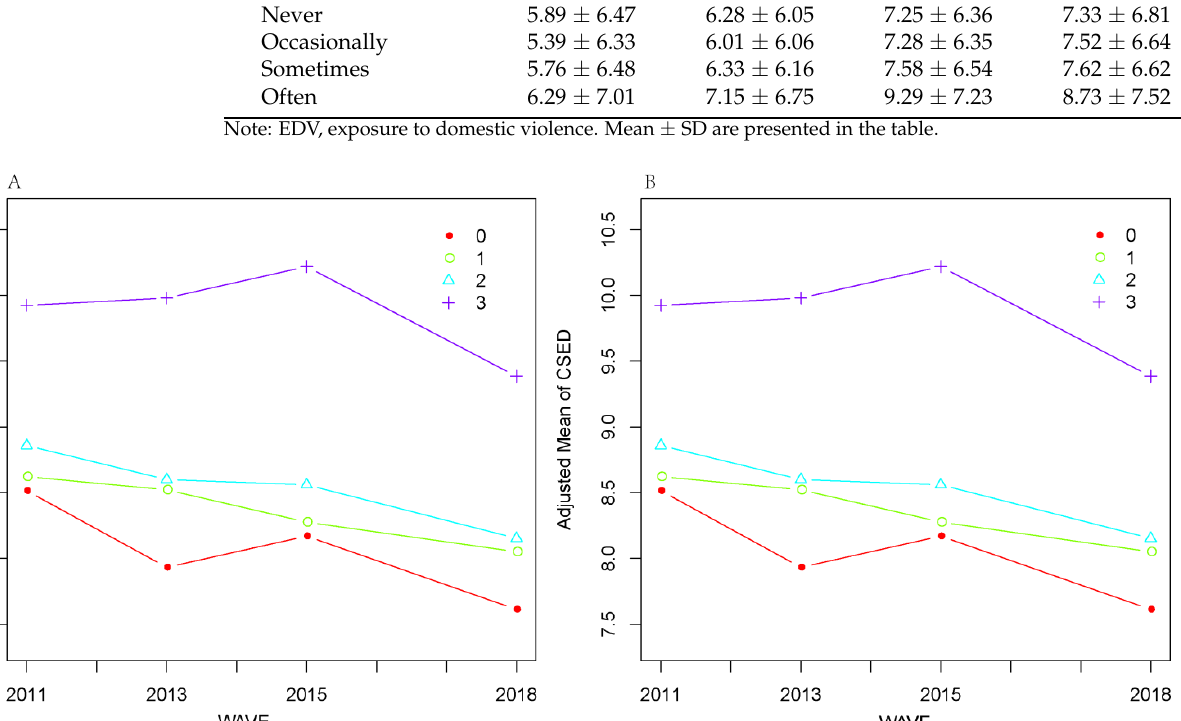
Table 3. Association between EDV and depressive symptoms based on random-effects linear regres- sion.